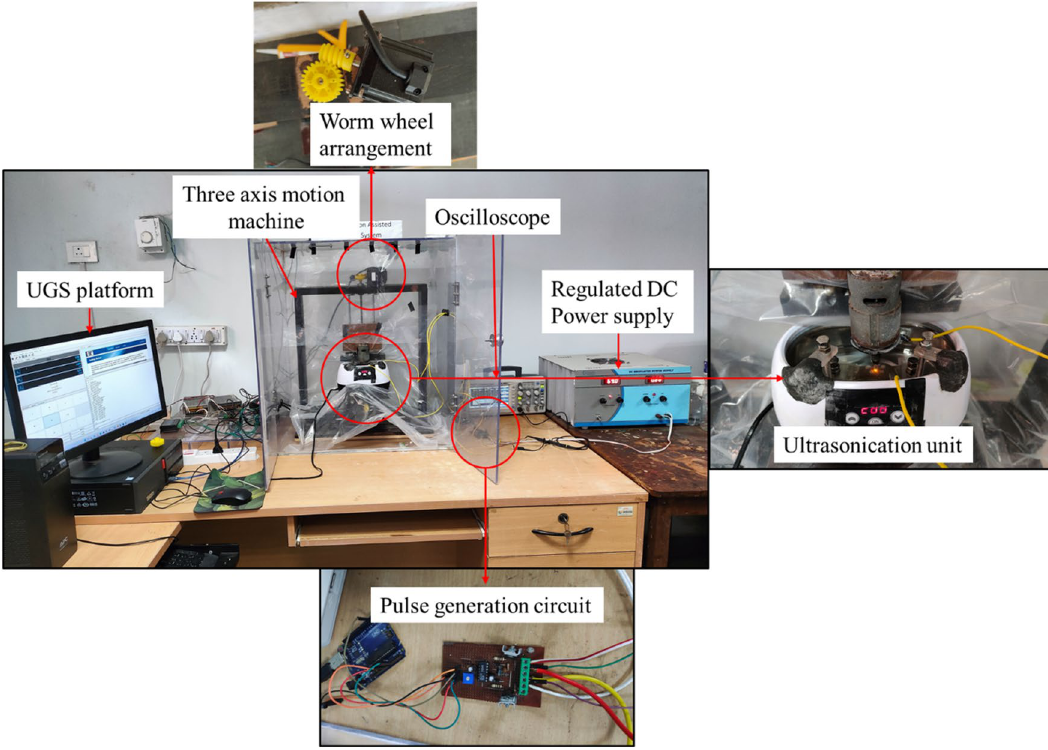
Figure 3. Photographic view of the in-house developed ES-µ-ECDM experimental